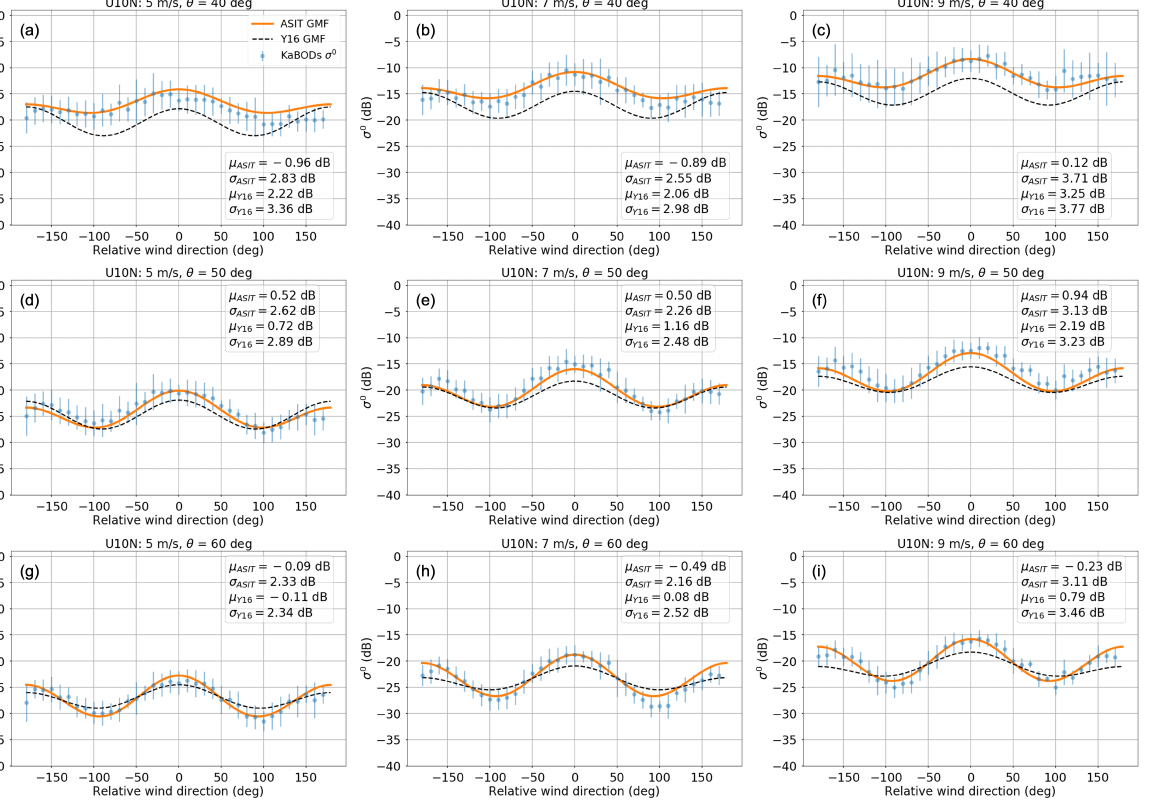
Figure 7. Ka-band sea surface backscattering coefficient at 40 deg ( a – c ) and 50 deg ( d – f ) and 60 deg ( g – i ) for different wind speed: 5 m/s ( left ), 7 m/s ( middle ), 9 m/s ( right ). The compari- son amongst the KaBODS observations averaged over 10 ◦ -bin (dots), the ASIT GMF (solid line) and the KaDPMod GMF from Yurovsky et al. (dashed line) is